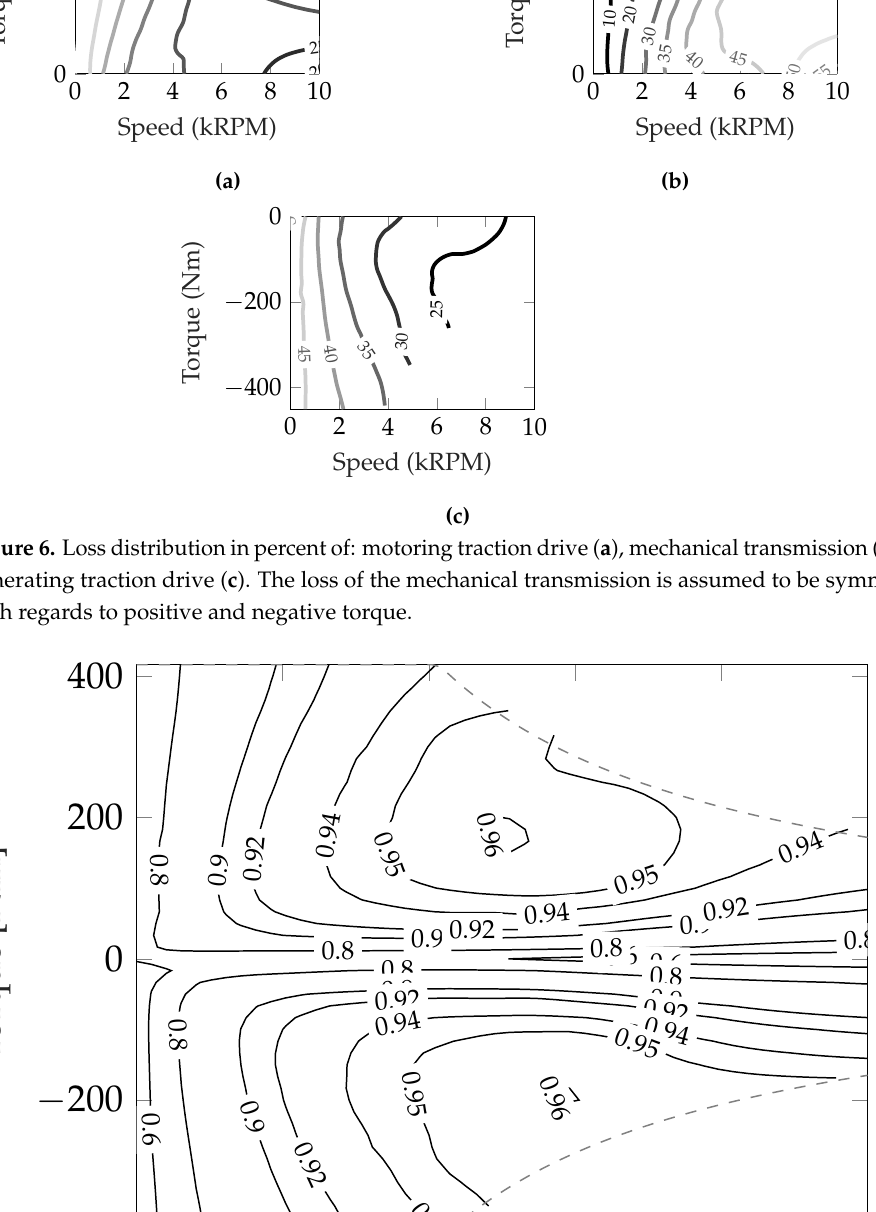
Figure 8. Efficiency of the DC/DC converter. be found in literature [33] - [35]. Since the purpose of this paper is not to make a finals 258